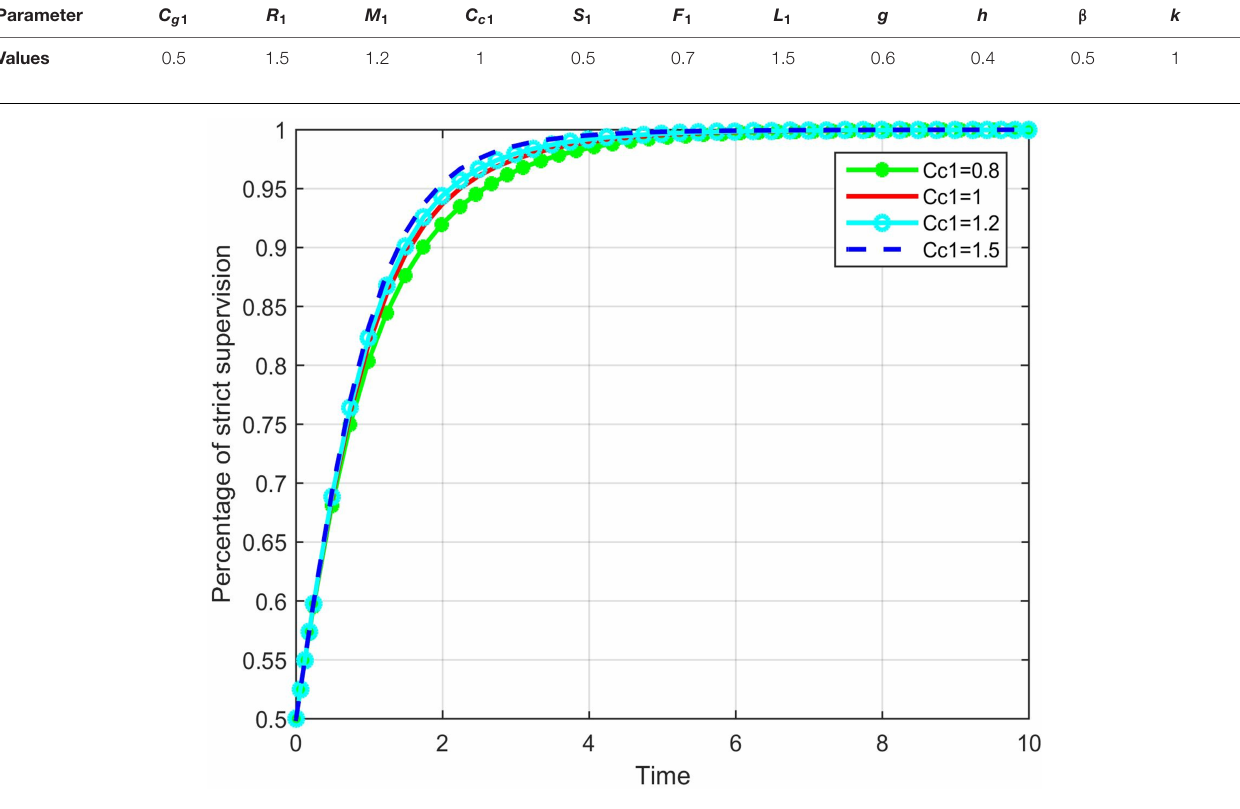
FIGURE 2 | The impact of C c 1 on the evolution trend of government strict